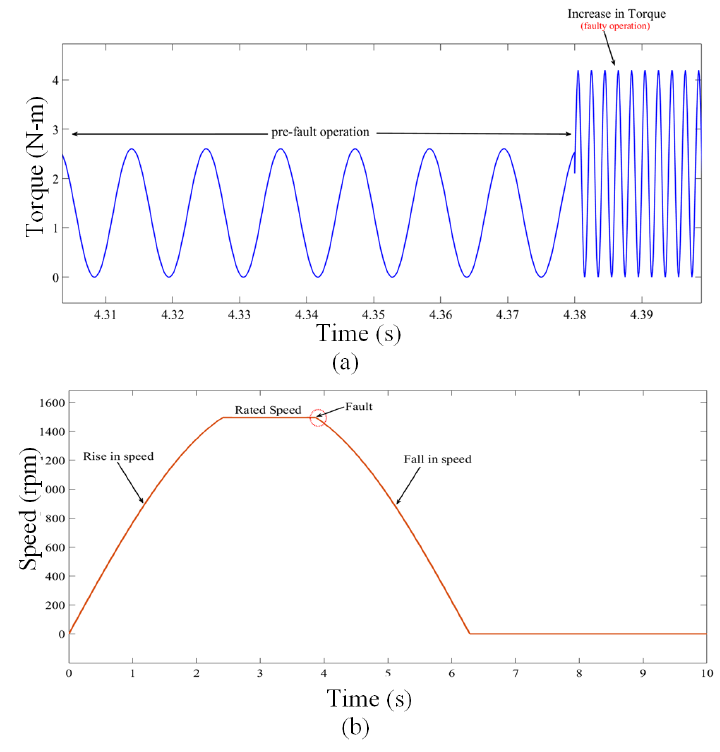
Figure 8. Motor performance under faulty operation: ( a ) Torque response; ( b ) speed